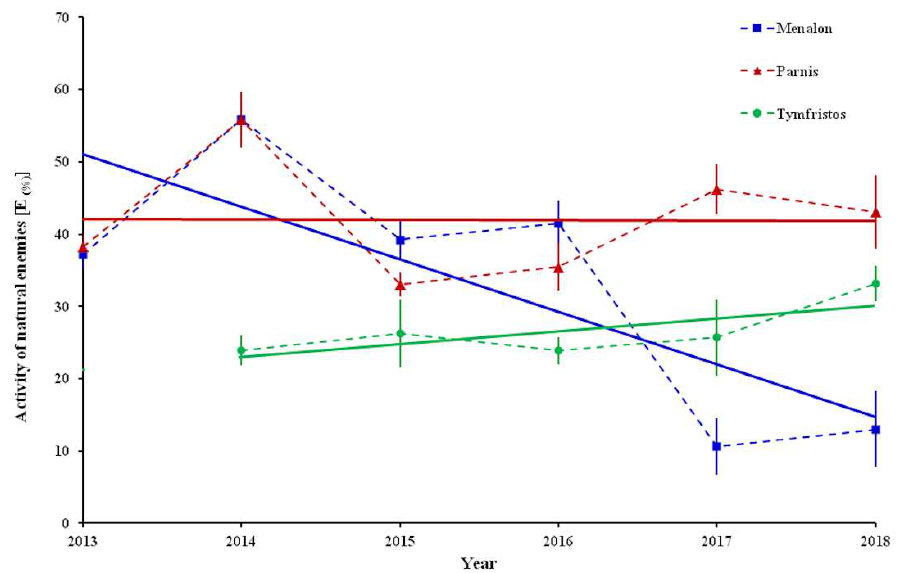
Figure 5. Activity of natural enemies [E (%) ] (mean ± SE) of adult females of P. hellenicus during the sampling period 2013–2018 at Menalon and Parnis and 2014–2018 at Tymfristos. Red, blue and green lines indicate the trends of mean values of Menalon, Parnis and Tymfristos, respectively. All main effects and the associated interactions were significant (Table 4). At Menalon, the parasitoid Pseudorhopus testaceus (Ratzeburg) (Hymenoptera: Encyrtidae) (14.0%), the predators (9.2%) and the “undefined” factor (11.3%) were significantly higher than the parasitoids Anthribus fasciatus Förster (Coleoptera: Anthibidae) (4.6%) and Micro- terys lunatus (Dalman) (Hymenoptera: Encyrtidae) (3.7%) (Table 5). At Parnis, P. testaceus